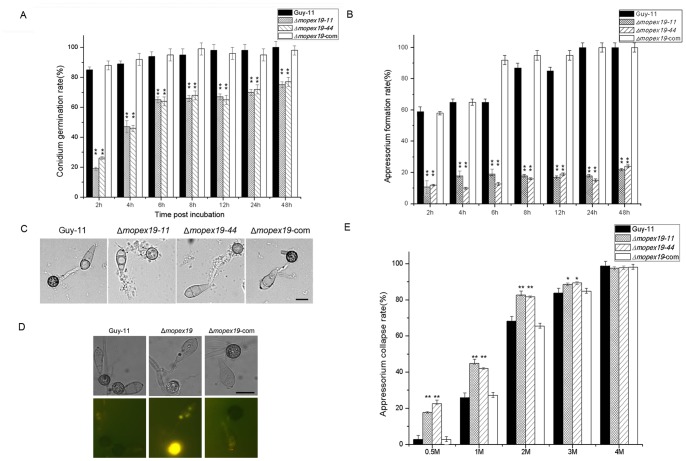
Conidial germination and appressorial formation of Δmopex19.The conidial germination rates (A) and appressorial formation rates (B) of Δmopex19, wild-type and complemented strains on hydrophobic surface were calculated. (C) Conidia and appressoria incubated for 12 h. The appressoria of Δmopex19 were less pigmented than those of the control strains, and cellular leakage occurred in the germ tubes and appressoria of Δmopex19. (D) Nile red staining showed that more lipid residues were present in the conidia and germ tubes of Δmopex19 incubated for 24 h. (E) Cytorrhysis assay to compare the appressorial turgor genesis of Δmopex19 and the controls. The 24-h appressoria were soaked in glycerol and the rates of cytorrhysis were calculated. Means and standard errors were calculated from three independent repeats (at least 100 conidia of each strain were measured for each repeat). Single asterisks indicate significant differences at P<0.05 and double asterisks indicate P<0.01.